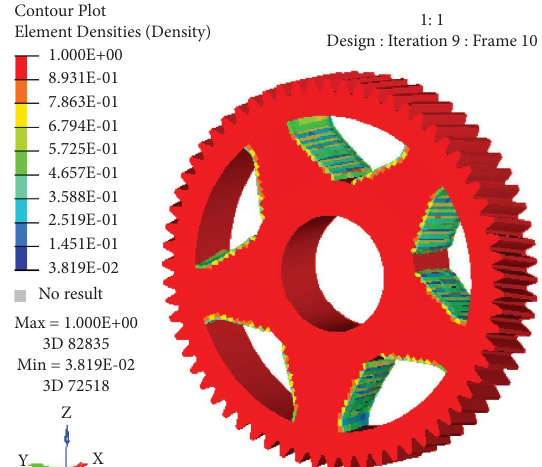
Figure 10: Schematic of the results of multiobjective topology optimization.